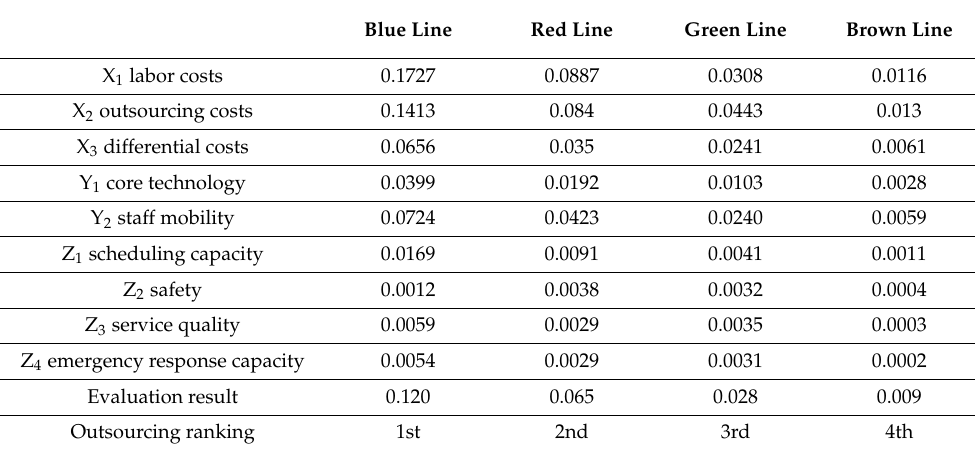
Table 8. Analysis of outsourcing priority of the four metro